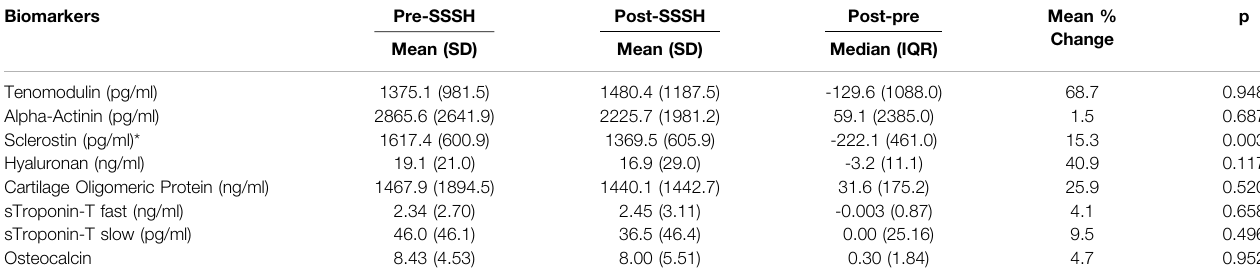
* Indicates pre-SSSH and post-SSSH values signi fi cantly different (Wilcoxon Signed Ranks Matched Paired test) (SD = standard deviation; IQR = interquartile range).